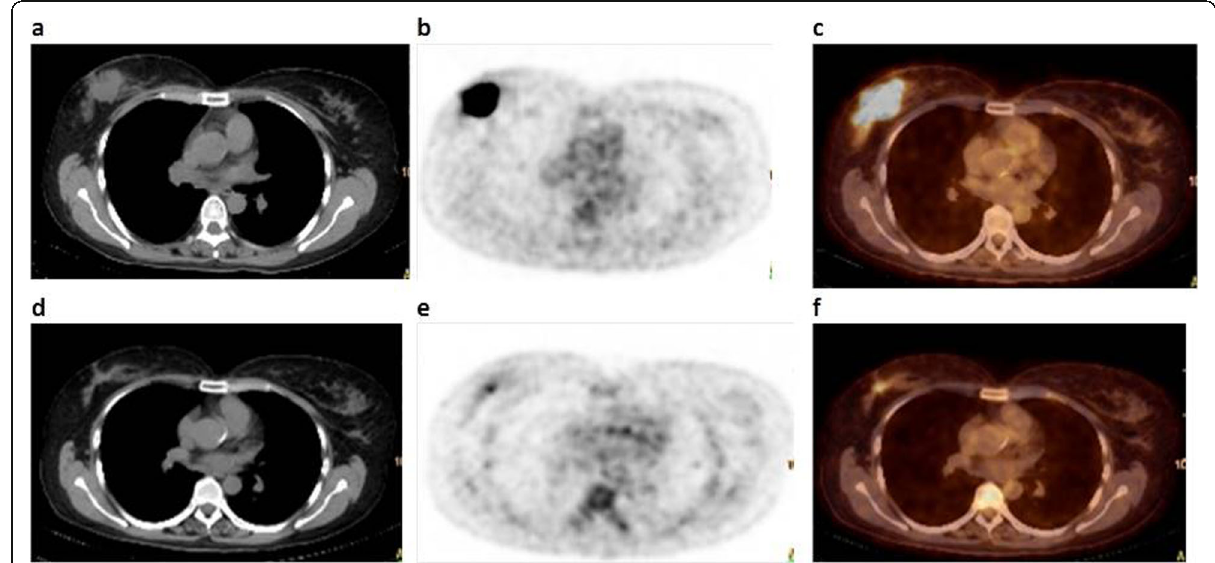
Fig. 3 48 years old female patient presented with clinically palpable right breast mass biopsy revealed IDC grade III. a Axial CECT image revealed right breast speculated soft tissue mass lesion measuring about 55 × 60 mm that was eliciting dense tracer fixation reaching 13.5 SUL peak in axial PET ( b ) and fused PET/CT ( c ) images. On follow-up after completion of chemotherapy, marked morphologic and metabolic regression of the mass was noted in the form of reduction in size (reaching 10 × 12 mm) in axial CECT image ( d ) denoting partial response and reduction in SUL peak (reaching 2.7) in axial PET ( e ) and fused PET/CT ( f ) images denoting partial metabolic